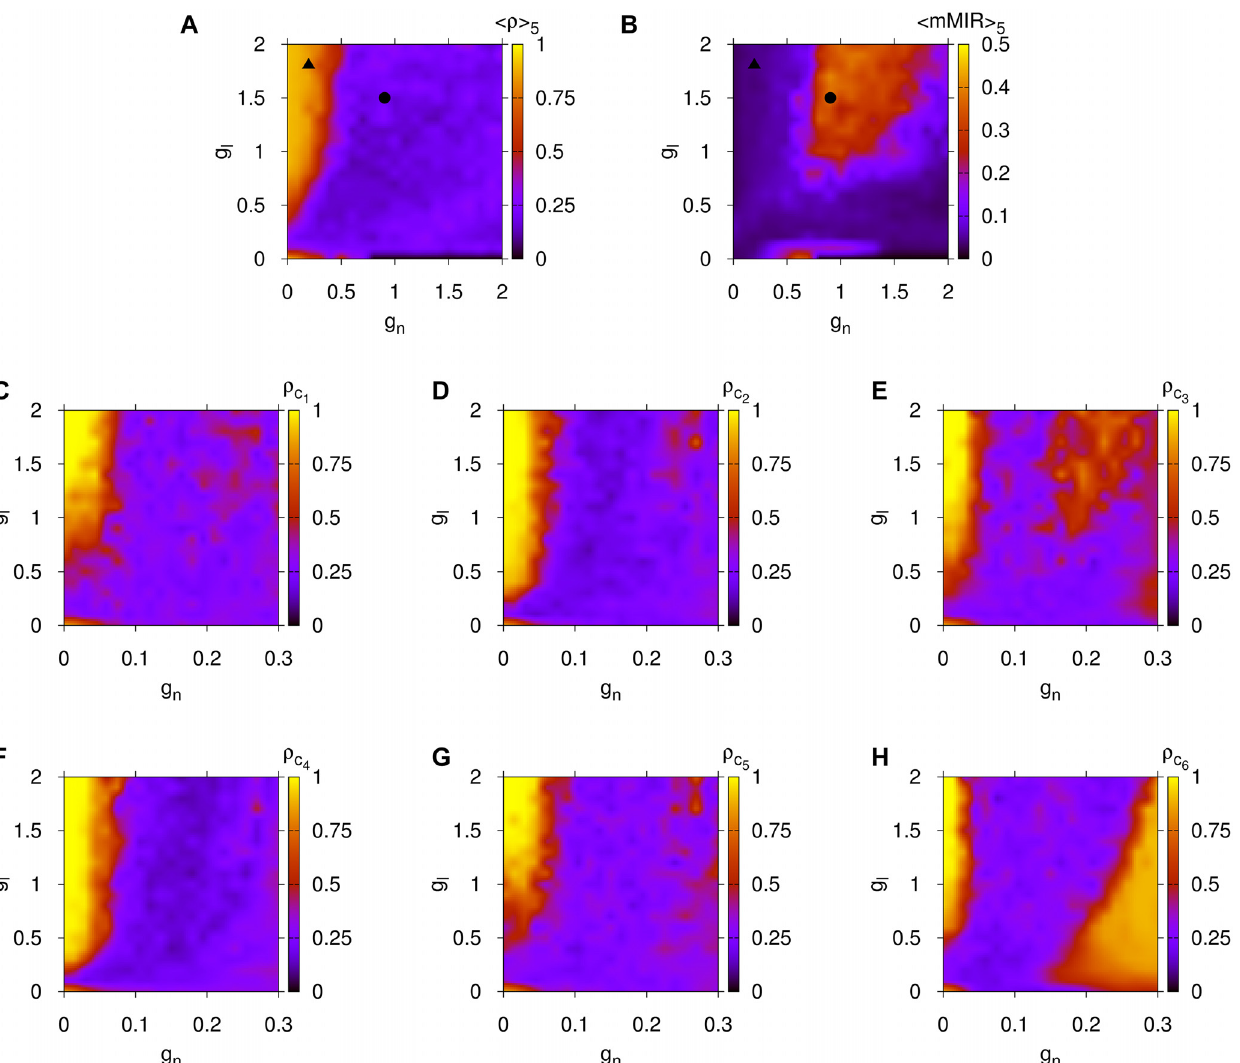
Fig 3. Results for the global and local synchronization, and information flow capacity properties for the evolved networks of Materials and Methods, Subsection A Model for Brain Network Evolution Based on the Maximization of Information Flow Capacity. Panel (A): Parameter space for the synchronization h ρ i 5 . Panel (B): Parameter space for the averaged upper bound for MIR, h mMIR i 5 , from the five realizations of a network of 60 neurons with six, equally sized, small-world clusters. Case A of high synchronization and low information flow capacity is denoted by ▲ and case B of low synchronization and high information flow capacity by ● . Panels (C) to (H) are plots for the local synchronization ρ c brain network. To be compared with panel (A). Here, g n is the chemical and g l the electrical coupling of Eq (2).